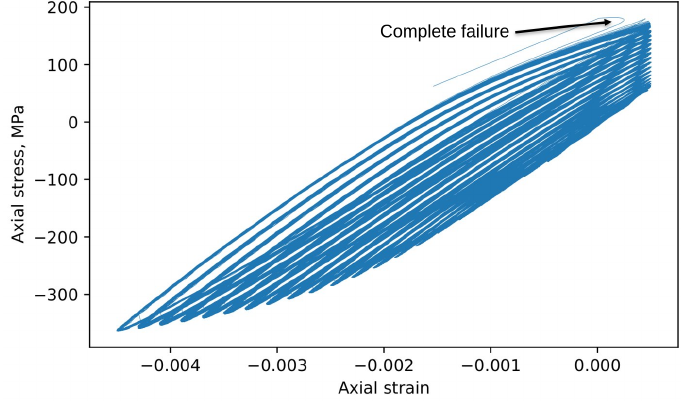
Figure 7. Experimental results for low cycle fatigue at room